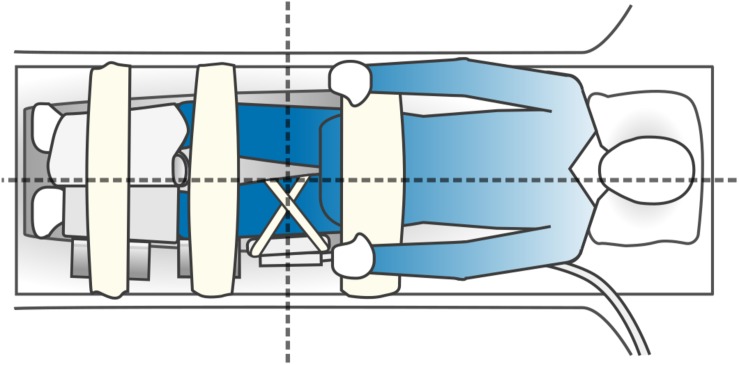
An illustration of participant setup for phosphorus magnetic resonance spectroscopy (31P-MRS). Subjects were positioned feet-first and supine in the bore of the MRI scanner, with a foam wedge under their knees and with the 10 cm 31P-MRS coil attached over their left vastus lateralis muscle using hook-and-loop straps. Participants were asked to shift to their right on the table to place the sensitive volume of the coil close to the magnet’s isocenter, which is indicated by the intersection of the dashed lines. A lower-leg positioning pad and a blanket were then placed over the shins as part of an exercise procedure performed subsequent to the rest MRS protocol detailed in this study. Wedges were placed at the left knee and shin to keep the left leg straight, and hook-and-loop straps and were affixed to the table over the hips, knees, and shins to limit gross displacements during the scan.